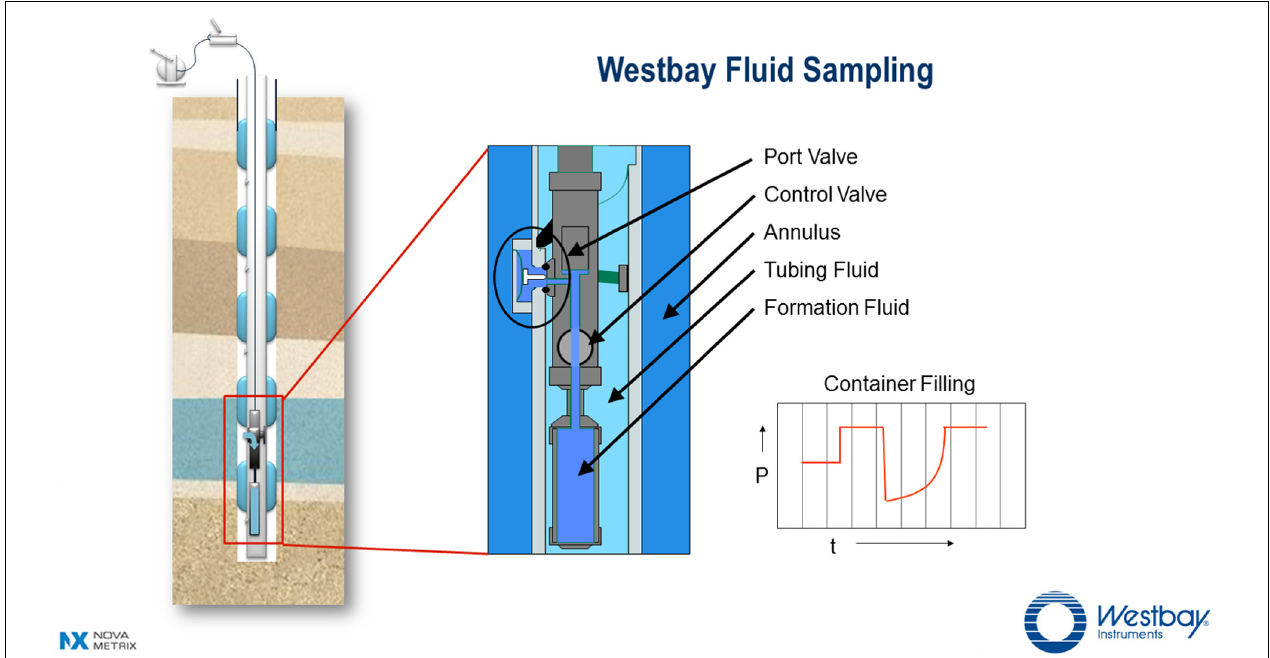
FIGURE 2 | Schematic of the Westbay System for multi-level groundwater monitoring (used with permission of Nova Metrix Ground Monitoring